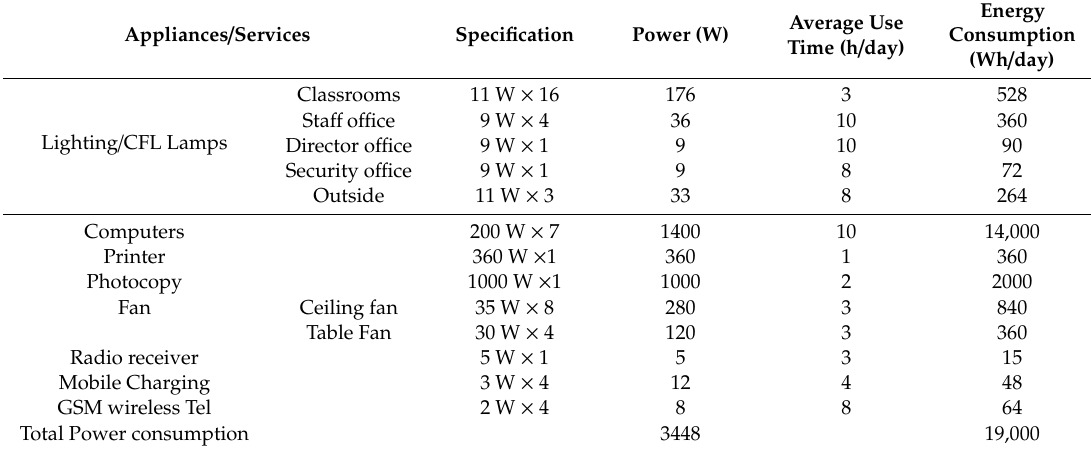
Table 1. Energy consumption of the school considering appliances with standard e ffi ciency [41–45]. Appliances / Services